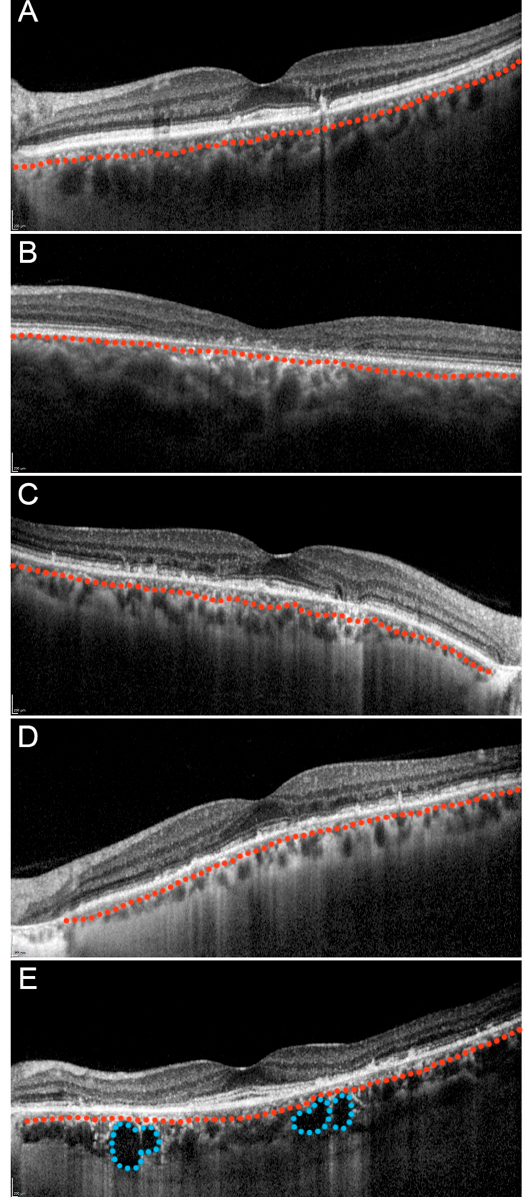
Figure 1. Choroidal patterns in Stargardt disease. A : Pattern 1 with a normal appearing choroid; B : Pattern 2 with a reduced Sattler layer; C : Pattern 2 with a reduced Haller layer; D : Pattern 3 with both reduced Sattler and Haller layers; E: Pattern 4 with reduced Sattler and Haller layers with choroidal caverns. In all images, Sattler and Haller layers are separated by a red dotted line. Moreover, choroidal cavers are highlighted by blue dotted lines.